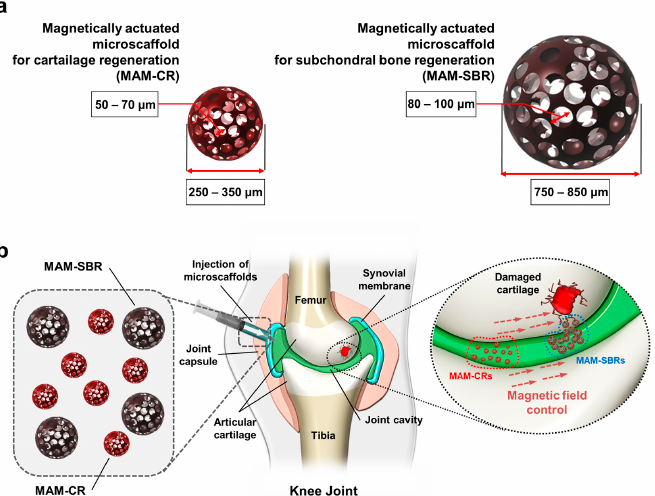
Figure 1. Conceptual overview of magnetically actuated microscaffolds with controllable magneti- zation and morphology for regeneration of osteochondral tissue. ( a ) Illustrations of magnetically actuated microscaffolds for cartilage regeneration (MAM-CR) and subchondral bone regeneration (MAM-SBR). ( b ) Targeted delivery processes of cell-loaded MAM-CR and MAM-SBR.